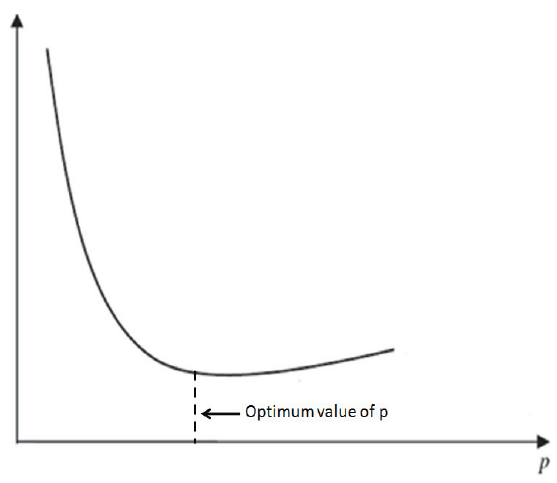
and R 2 in terms of p. p p